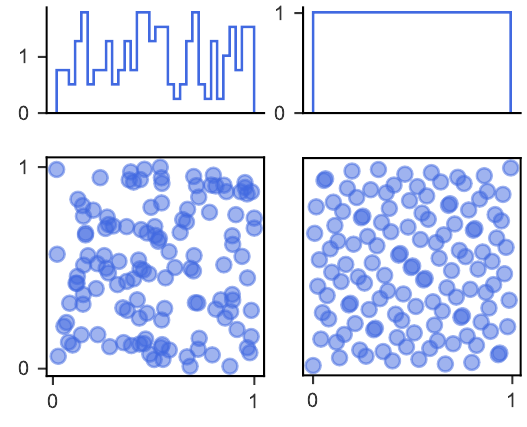
Figure 4. Random samples and Sobol’ sequence in two dimensions (2 7 = 128